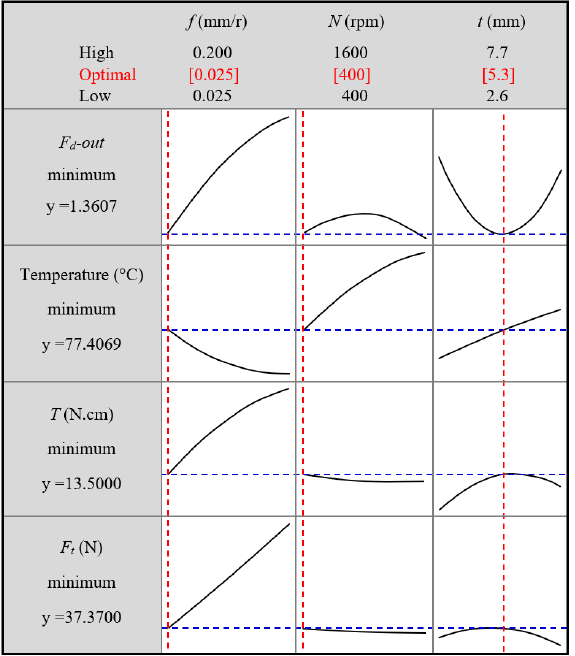
Figure 18. Optimum response according to different machining parameters.